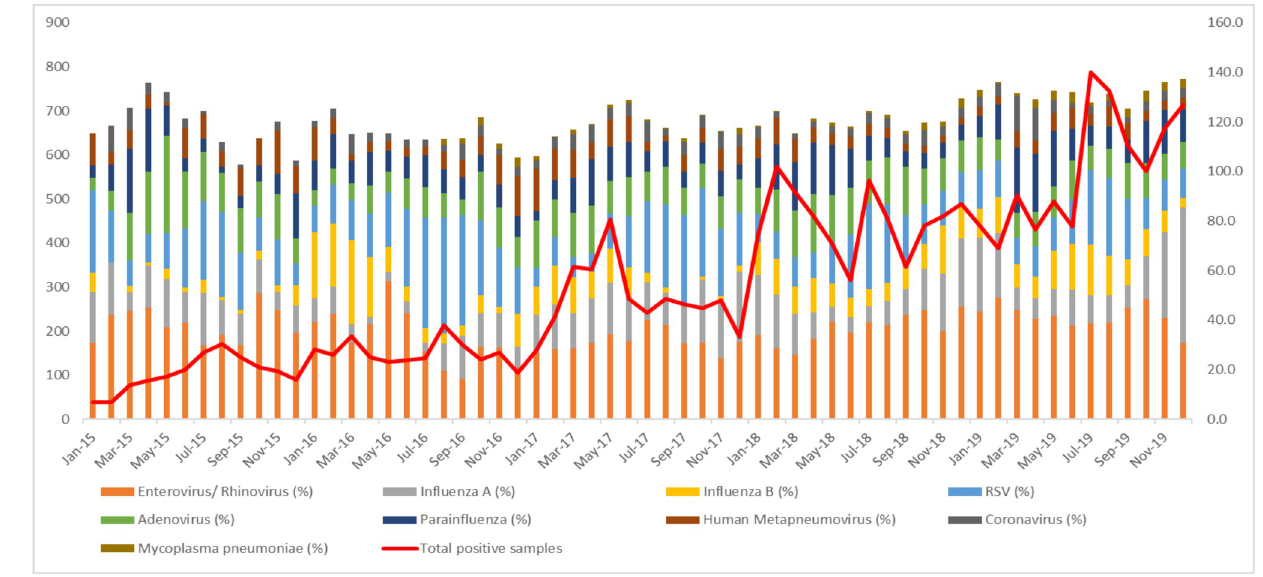
Fig 3. Monthly distribution of respiratory pathogens detected from January 2015 to December 2019.